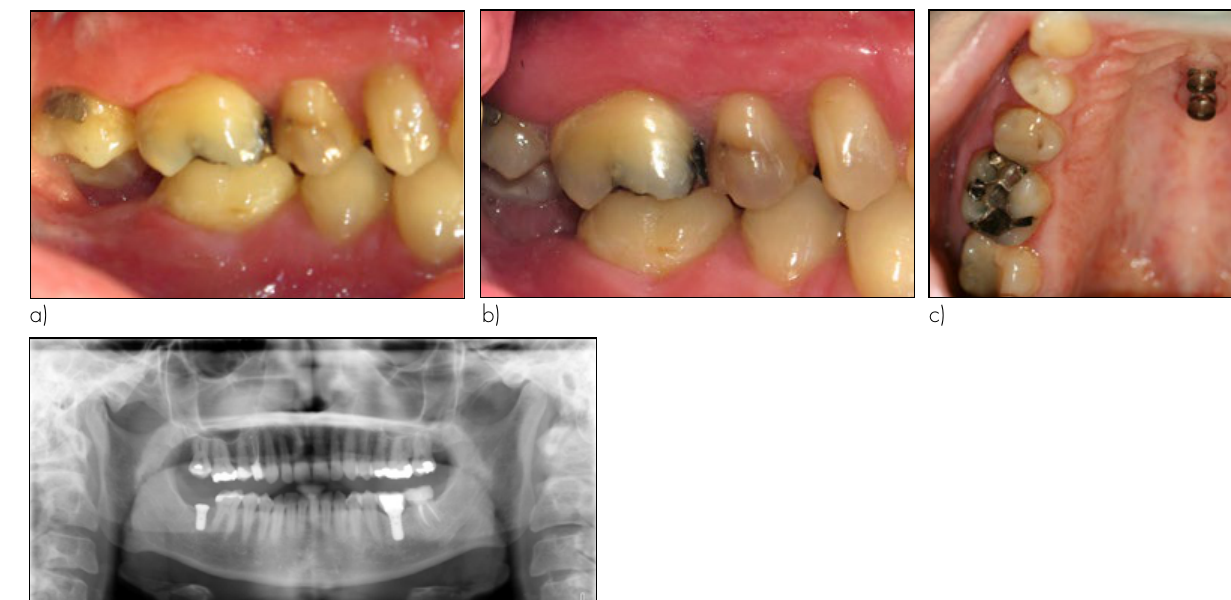
Figure 6. Intrusion of the molar after six (a) and nine (b-d)